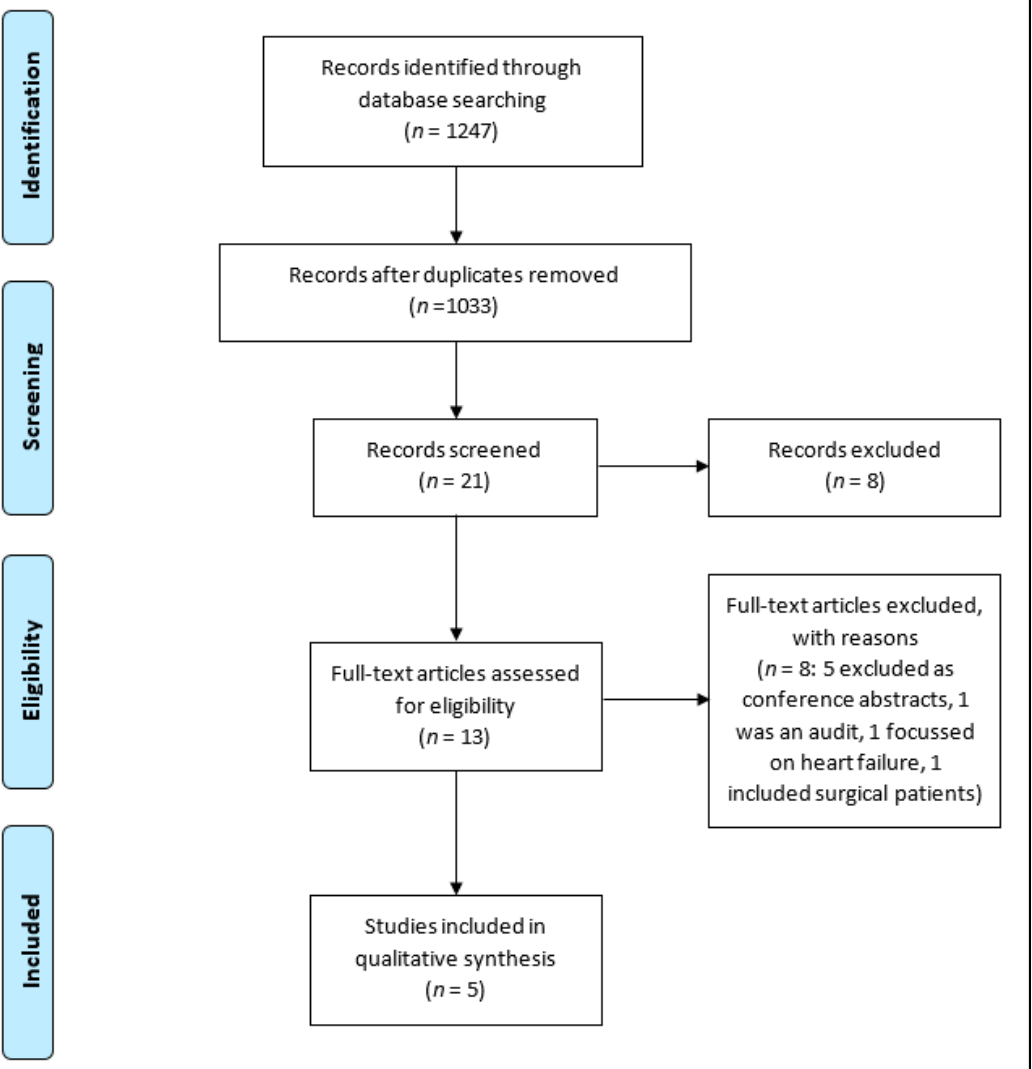
Figure 1. PRISMA flow diagram [23].